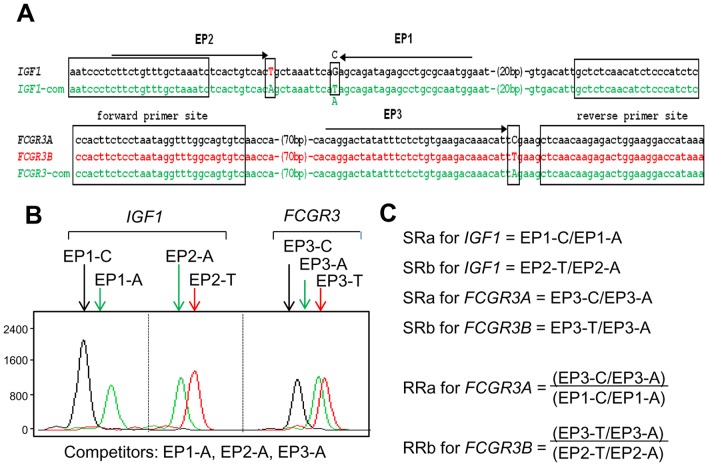
mrcPCR assay for determination of FCGR3A and FCGR3B copies.(A) Alignment of wild-type and competitor sequences for IGF1 and FCGR3 used in mrcPCR assay. The nucleotides corresponding to modified bases are indicated in upper-case letters. The forward and reverse PCR primer sites are marked in brackets. EP1, EP2, and EP3 represent the extension primer sites, with the direction of the extension indicated by arrows. (B) Electrophoregram of extended products in mrcPCR assay. Extended nucleotides are indicated after the extension primers. Four peaks originated from genomic IGF1 (EP1-C and EP2-T) and competitor IGF1 (EP1-A and EP2-A), and the other three peaks originated from genomic FCGR3A (EP3-C), genomic FCGR3B (EP3-T), and competitor FCGR3 (EP3-A). (C) Formula for the signal ratios (SRs) and the relative ratios (RRs) from peak heights of electrophoregram.